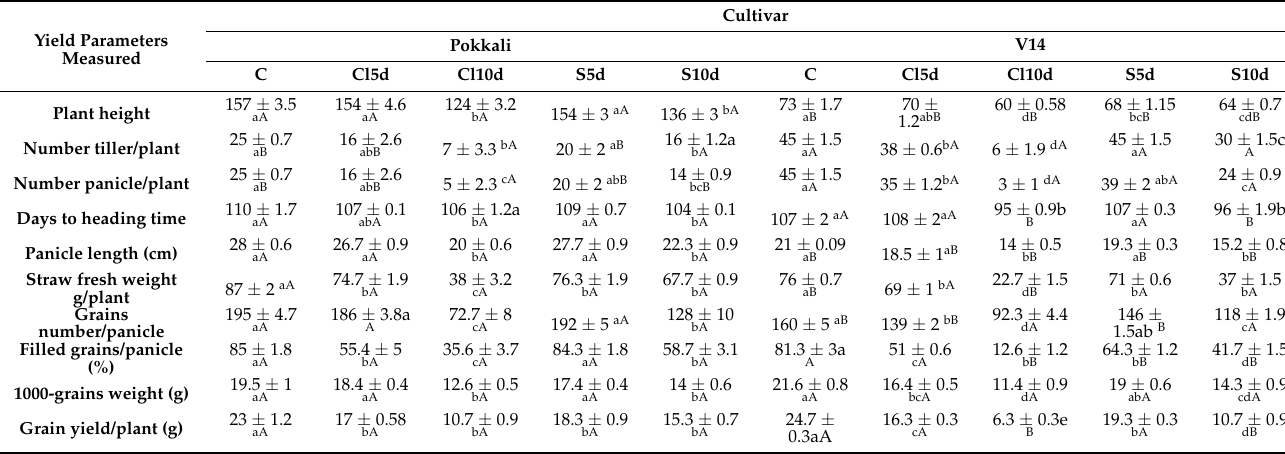
Table 4. Rice yield parameters measured on control plants (C) and plants stressed by 5 dS m − 1 (5d) or 10 dS m − 1 (10d) NaCl (Cl) or Na 2 SO 4 (S). Plants belong to two distinct cultivars (Pokkali: salt-resistant and V14: